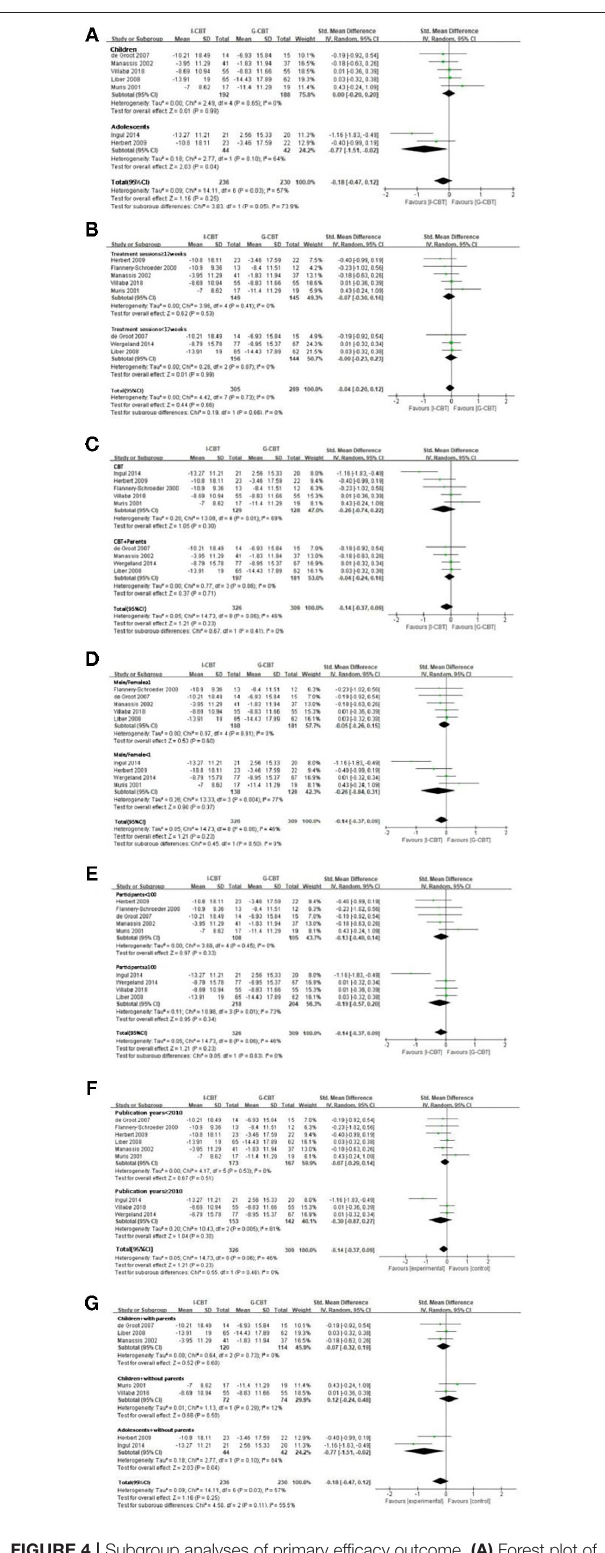
FIGURE 4 | Subgroup analyses of primary efficacy outcome. (A) Forest plot of standardized mean difference (SMD) for changed scores in anxiety disorder